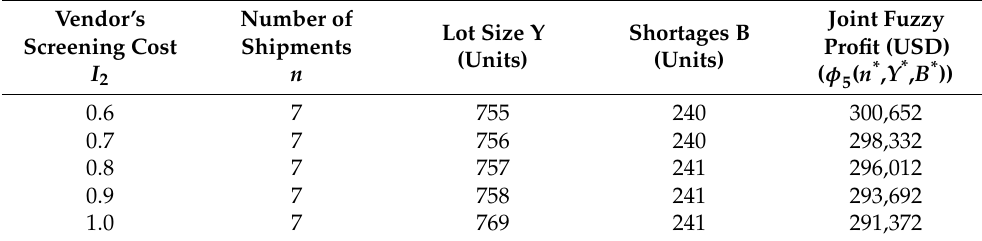
Table 22. Impact of the vendor’s screening cost on the decision variables and joint fuzzy profit.